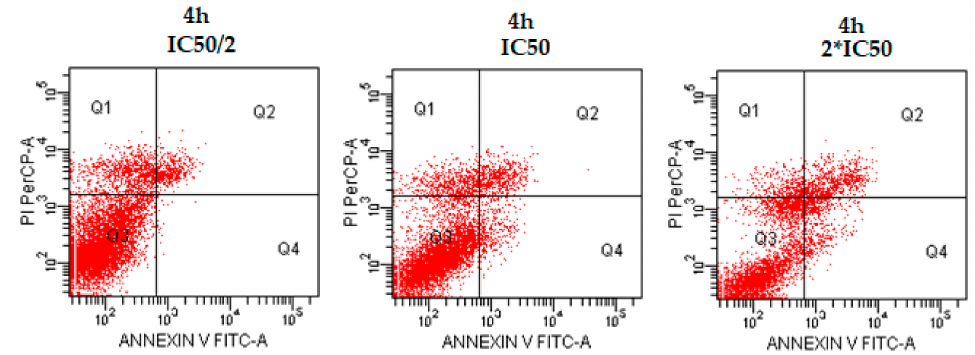
Figure 5. The flow cytometric analysis diagram of compound 4h and cisplatin for C6 cell line. Annexin V-PI analysis in C6 cell line, following 24 h incubation period of compounds 4h at IC 50 /2, IC 50 , 2 × IC 50 concentrations, which are 0.015, 0.03 and 0.06 mM, respectively, following a 24 h incubation period. FITC Annexin V method in C6 cell line, following 24 h incubation period of cisplatin at IC 50 (0.03 mM). Diagram can be divided into four regions that are defined as follows: the percentage of necrotic cells (PI/FITC. +/ − ; Q1); the percentage of late apoptotic cells (Q2; PI/FITC +/+); the percentage of viable cells (Q3; PI/FITC − / − ) and the percentage of early apoptotic cells (Q4; PI/FITC − /+). Percentages of Q1, Q2, Q3, and Q4 of compound 4h and cisplatin were presented in Table